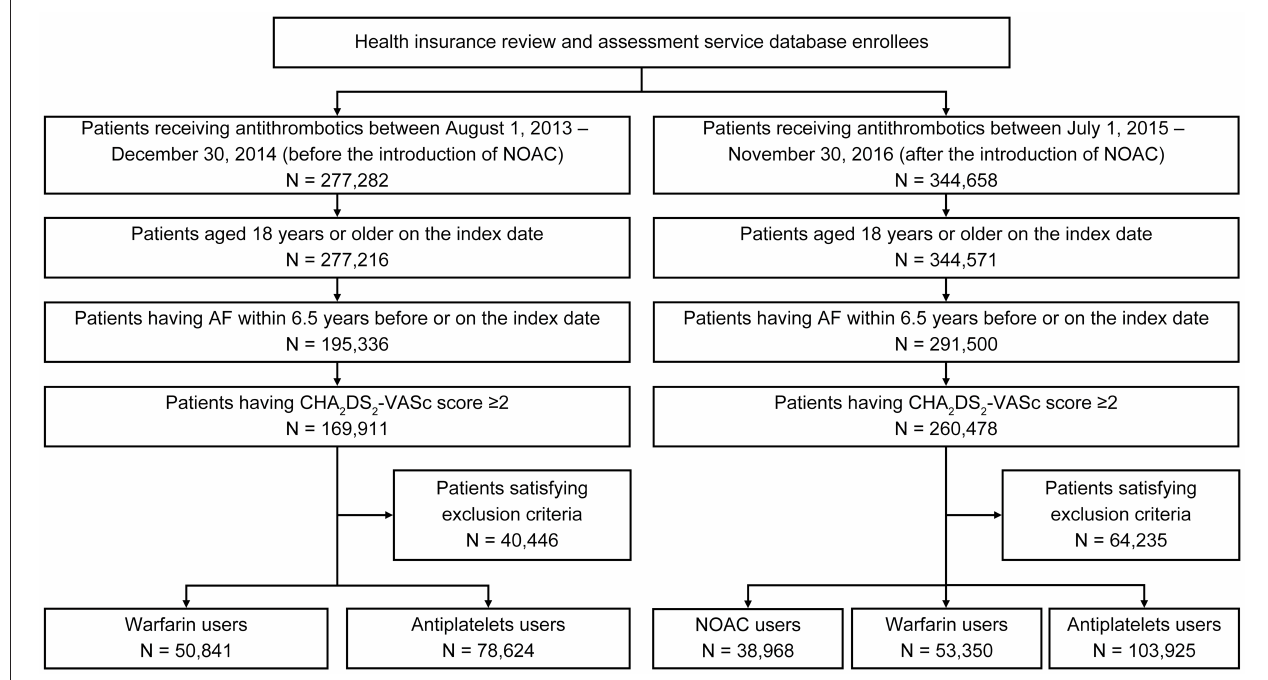
of antithrombotic based on CHA 2 DS 2 -VASc score, HAS-BLED score ( Supplementary Table 2 ), and comorbidity.